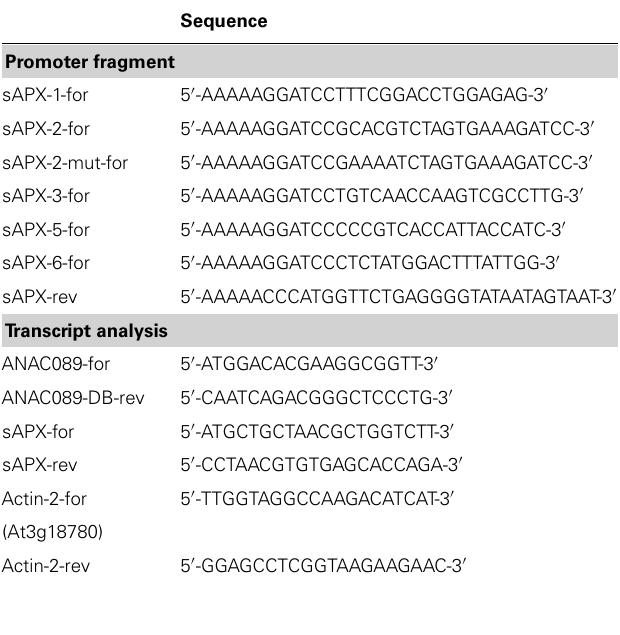
Table 1 | Oligonucleotide primers used for (a) cloning of the sAPX promotor fragments into the p35SYFP vector using Bam HI and Nco I restriction sites and (b) transcript